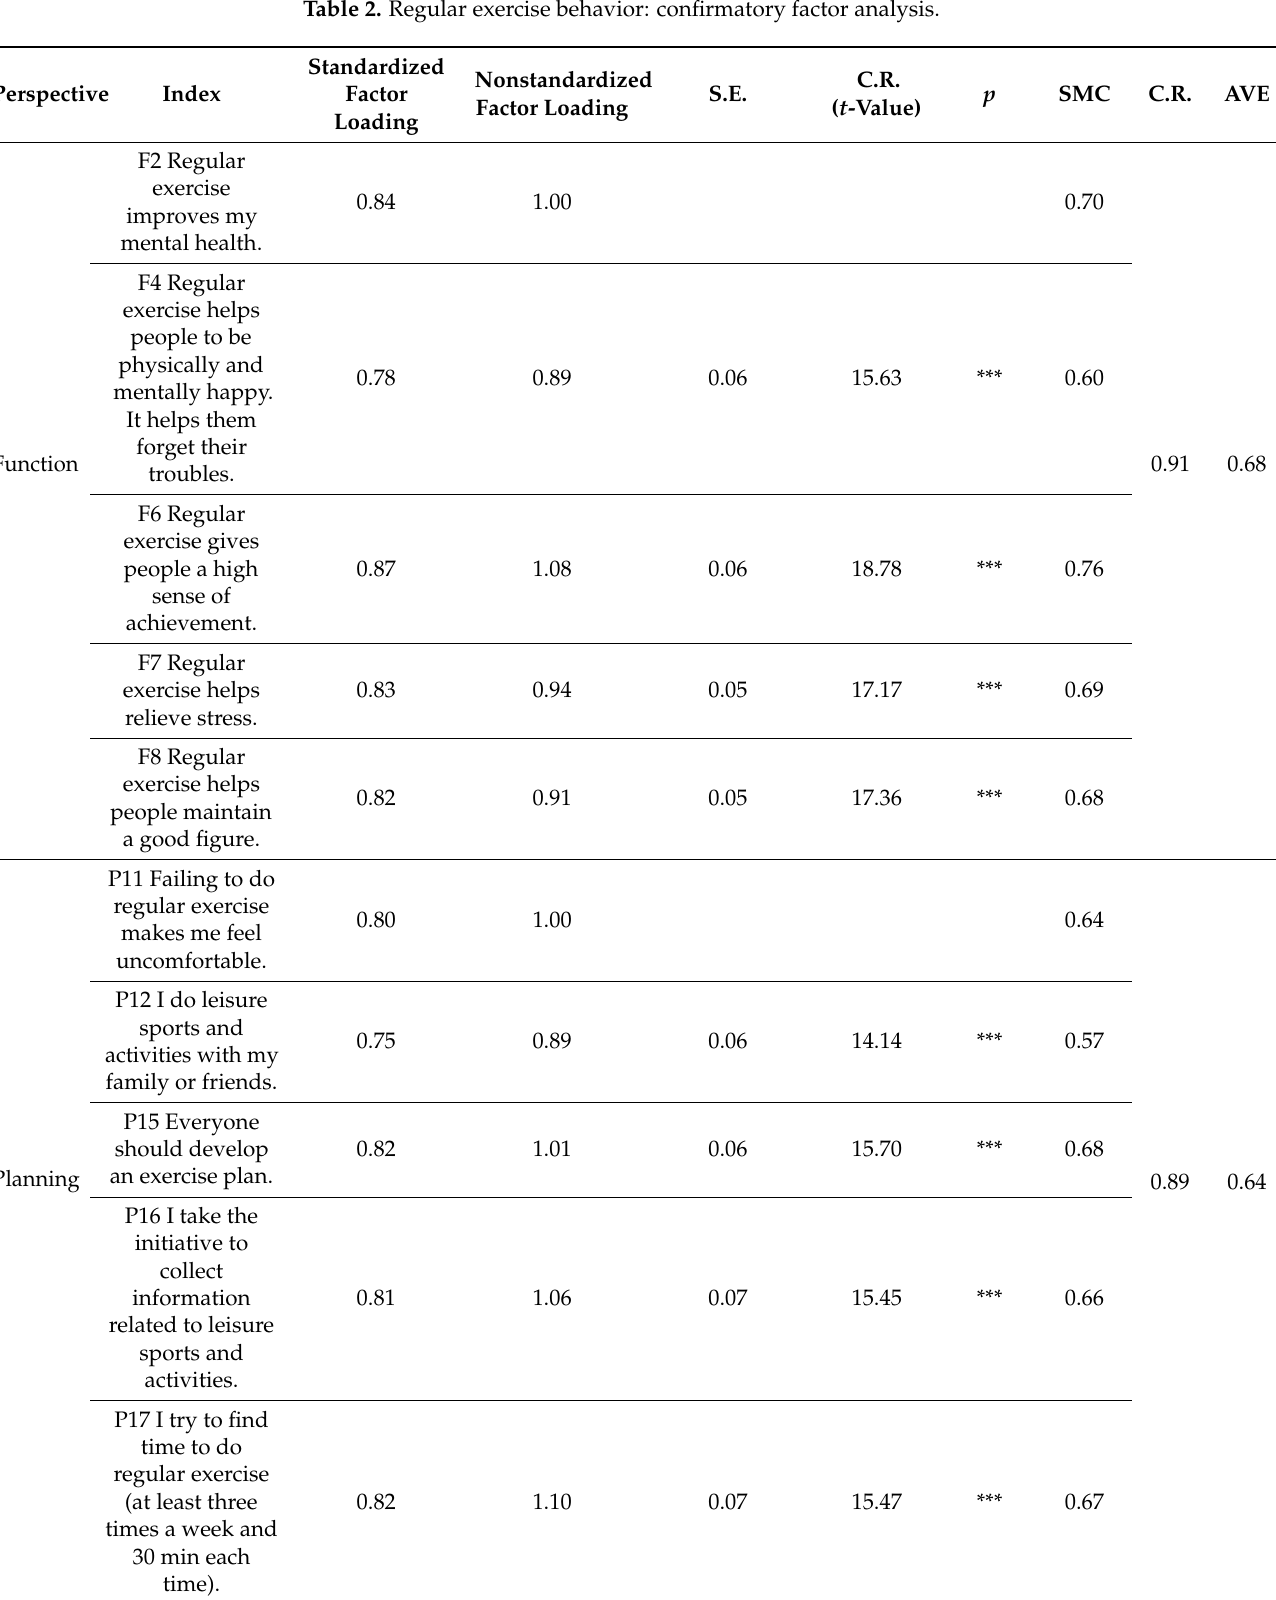
Table 2. Regular exercise behavior: confirmatory factor